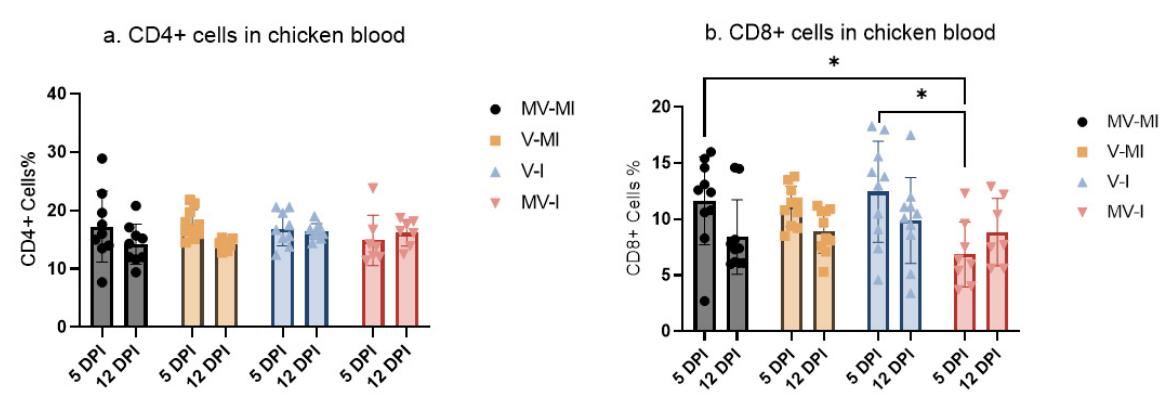
Figure 7. Percentage of ( a ) CD4+ and ( b ) CD8+ T cells in peripheral blood mononuclear cells (PBMCs) at 5 and 12 dpi. Mean percentage of CD4+ and CD8+ T cells is given, and error bars represent the standard error of means (SEM). Kruskal–Wallis test was performed followed by Dunn’s multiple comparison test to identify the group differences. * = p < 0.05.